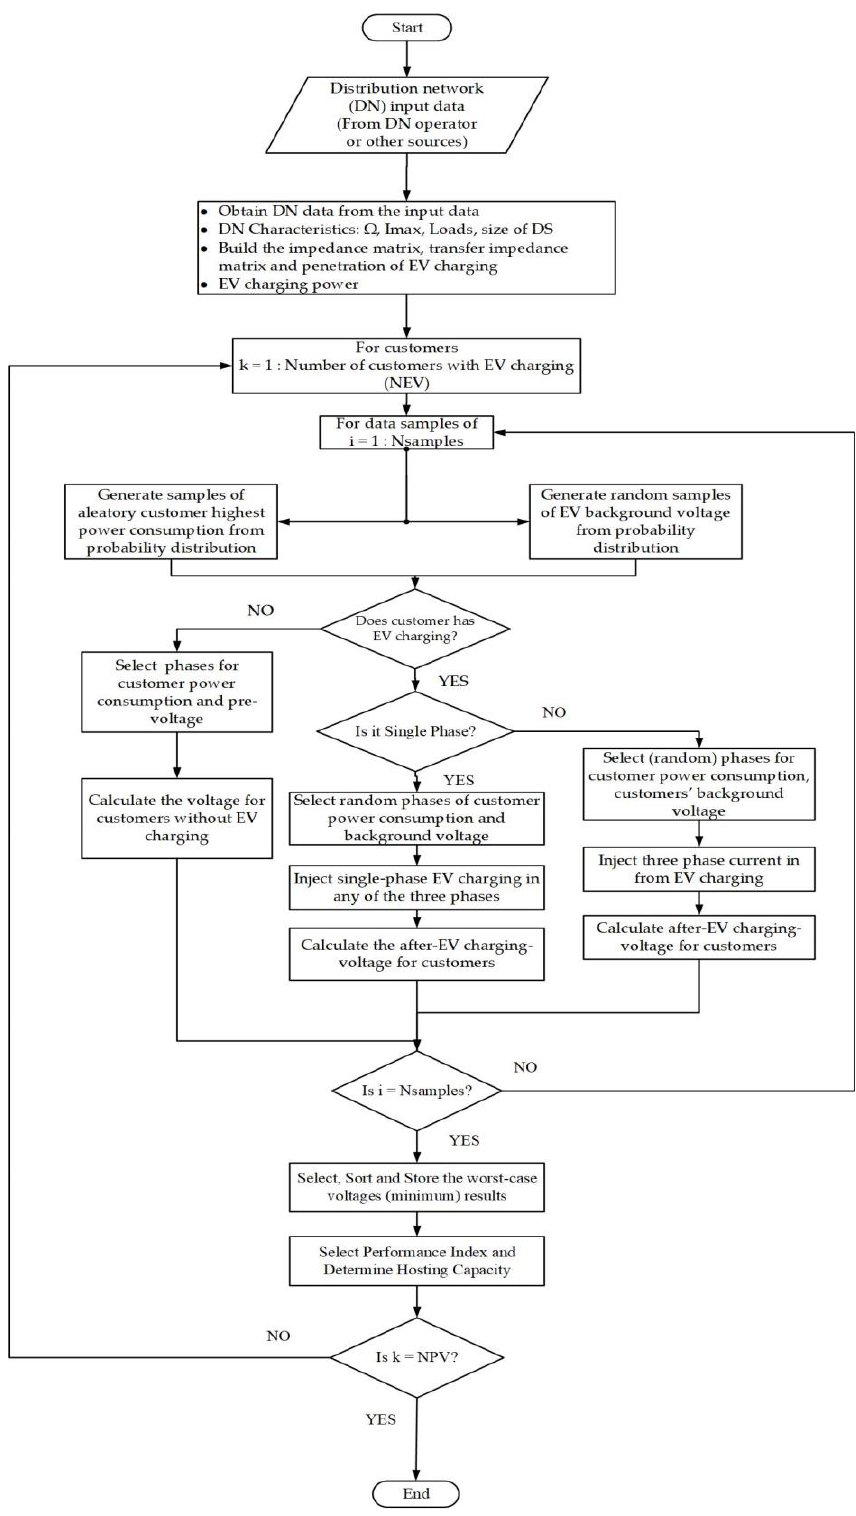
Figure 1. The flow chart for the stochastic hosting capacity approach for EV charging in a distribu- Figure 1. TheflowchartforthestochastichostingcapacityapproachforEVcharginginadistribution tion network.